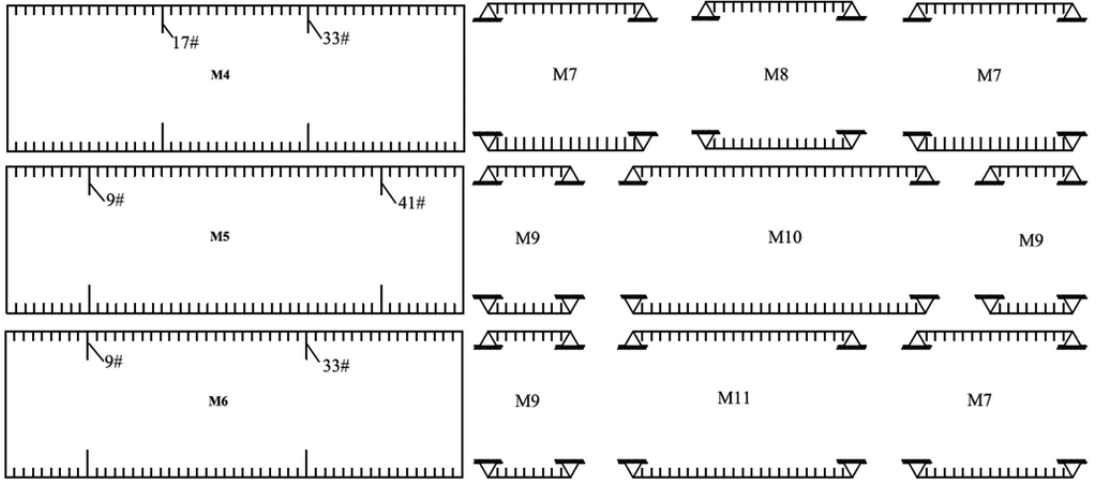
Fig. 15. Cylindrical shells with two frame ribs and separate cabins divided by frame